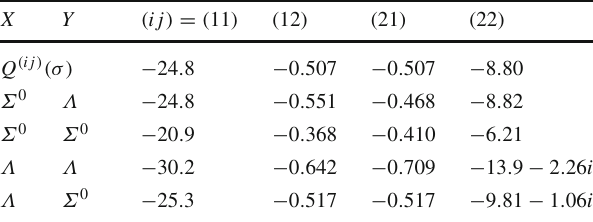
Table 2 Analytic result Q ( ij ) (σ) compared to the numerical result for ˆ Q ( ij ) (σ,ρ) evaluatedbeyondthe ρ → 0limit,where,ofcourse,thereal XY part gains the dependence on X and Y . The values are to be multiplied by 10 − 3